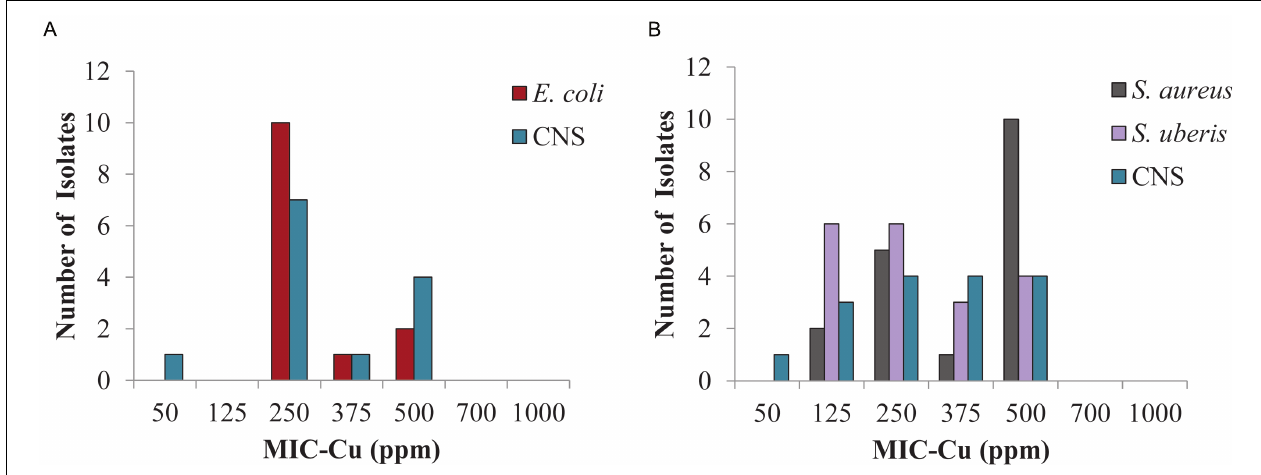
FIGURE 3 | Minimum inhibitory concentration of copper (MIC-Cu) value distribution for the most prevalent isolates from clinical bovine mastitis. Isolates from: (A) central region and (B) southern region.